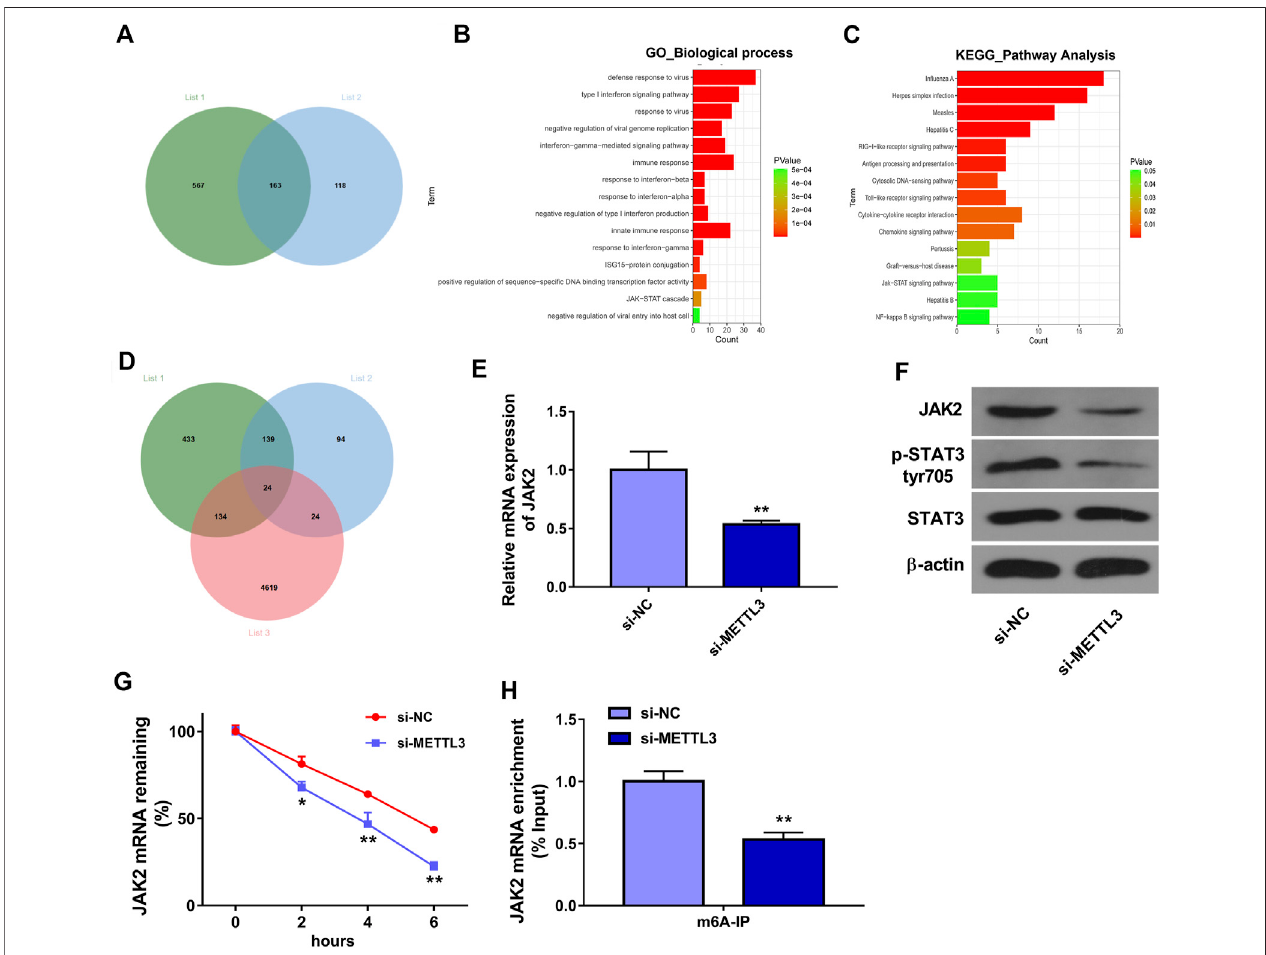
FIGURE 3 | METTL3 positively regulated JAK2/STAT3 pathway by in fl uencing the stability of JAK2 mRNA in an m6A-dependent manner. (A) Venn analysis for genes in Supplementary Tables S1, S2 . (B) The top 15 biological process terms enriched by the common genes in Supplementary Tables S1, S2 . (C) The top 15 KEGG pathways enriched by the common genes in Supplementary Tables S1, S2 . (D) Venn analysis for genes in Supplementary Tables S1, S2, and S4 . (E – H) HUVECs were transfected with si-NC or si-METTL3 for 48 h (E) JAK2 mRNA level was measured through RT-qPCR assay. (F) Protein levels of JAK2, p-STAT3, and STAT3 were determined by western blot assay. (G) JAK2 mRNA stability was tested by ActD assay. (H) The m6A modi fi cation level in JAK2 mRNA was examined through MeRIP and RT-qPCR assay. Three independent experiments were performed for all in vitro assays. * p < 0.05, ** p < 0.01.